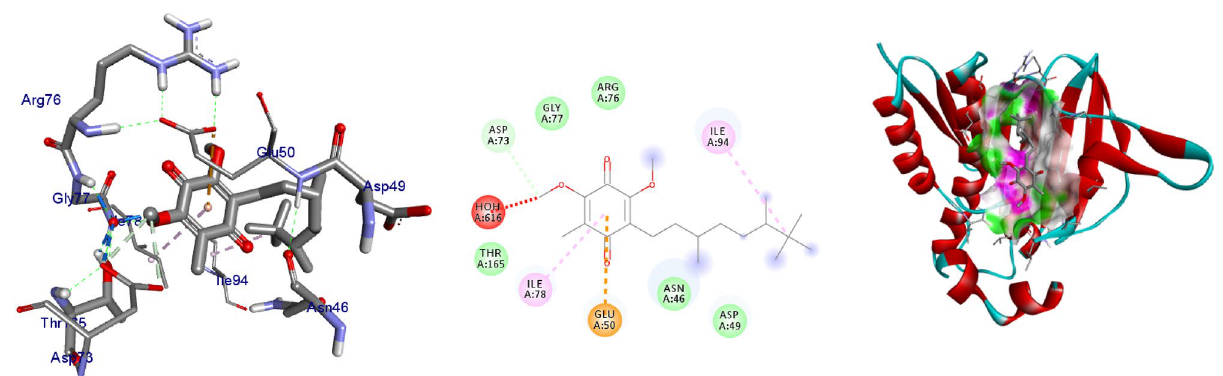
Figure 3. The 2D and 3D intermolecular contact between compound 2 and DNA gyrase B (PDB ID: 6F86). Chemical structures were drawn by ChemDraw Pro 16.0 Suite (PerkinElmer, USA) and analyzed by the Discovery studio visualizer (BIOVIA Discovery studio 2020